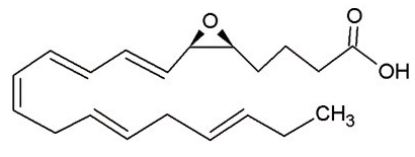
Figure 3. Leukotriene A 5 .